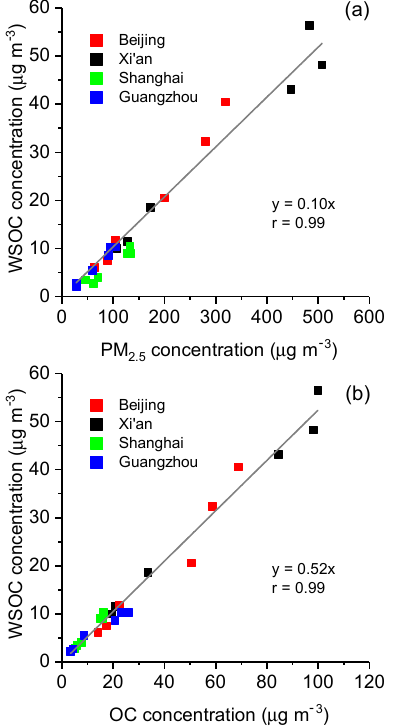
Figure 2. Linear relationships ( p <0.01) of WSOC with PM 2 . 5 (a) and OC concentrations (b)